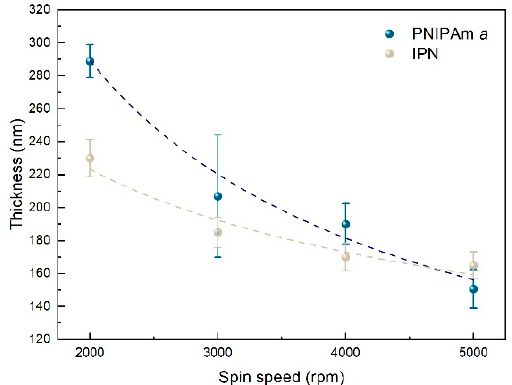
Figure 4. Thickness versus spin-speed for PNIPAm a and IPN films (concentration of 3 wt%) on glass-NaOH.